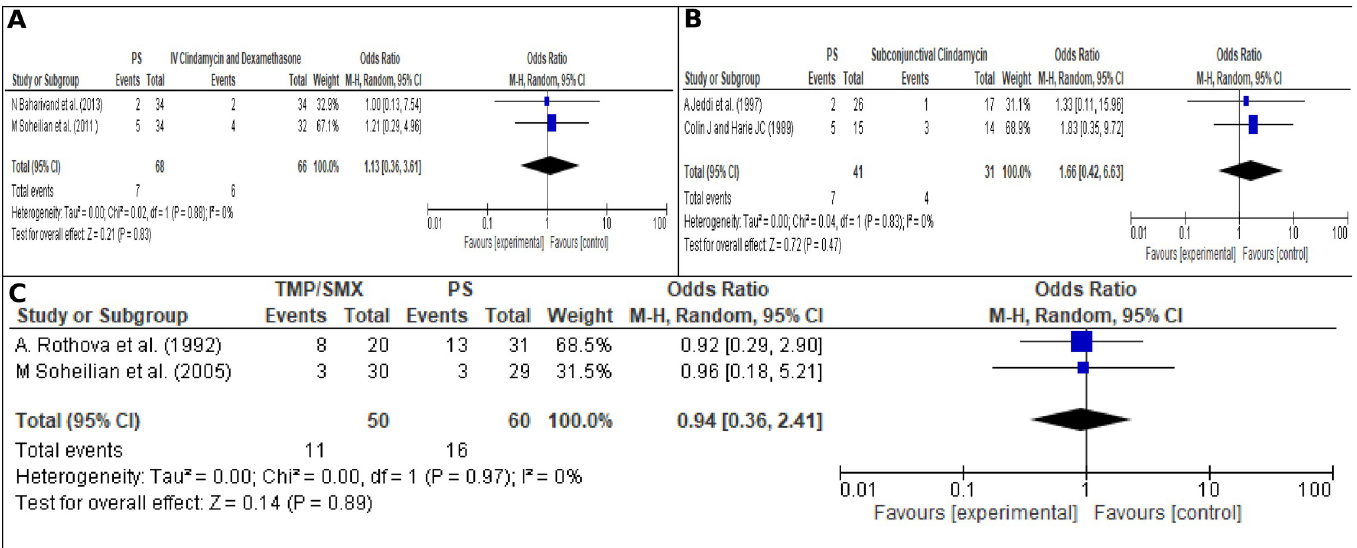
PLOS ONE | https://doi.org/10.1371/journal.pone.0283845 April 3,